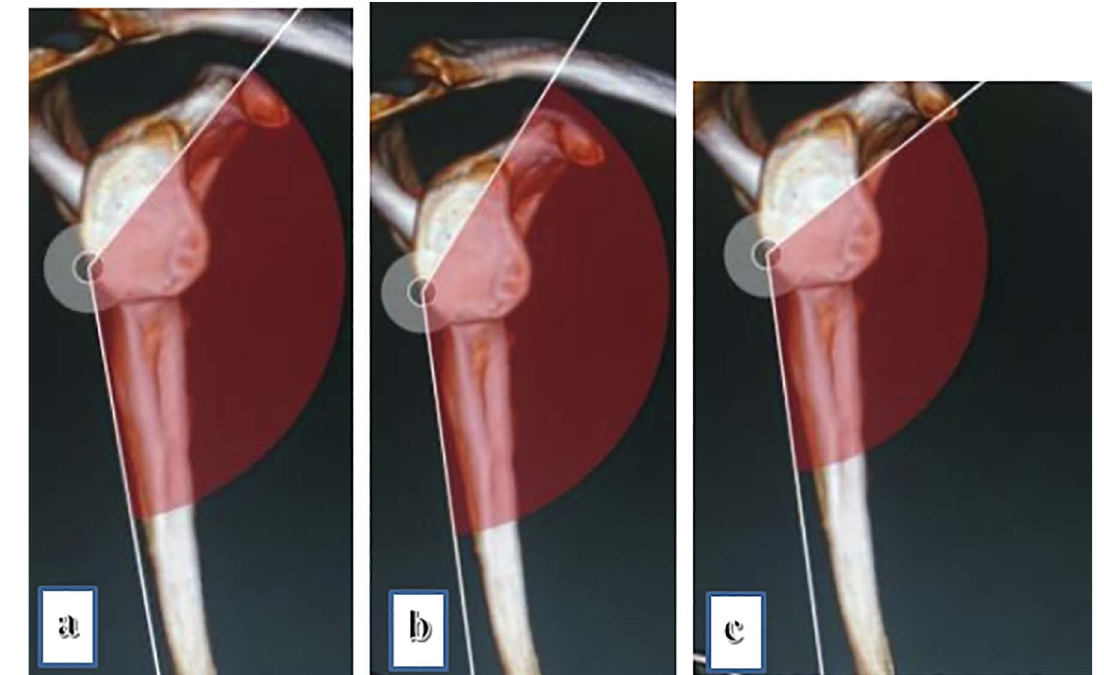
Figure 5. Effect of 10 degrees increase (b) and decrease (c) in sagittal inclination from the same entry point on fi nal screw position relative to the proper mean inclination angle